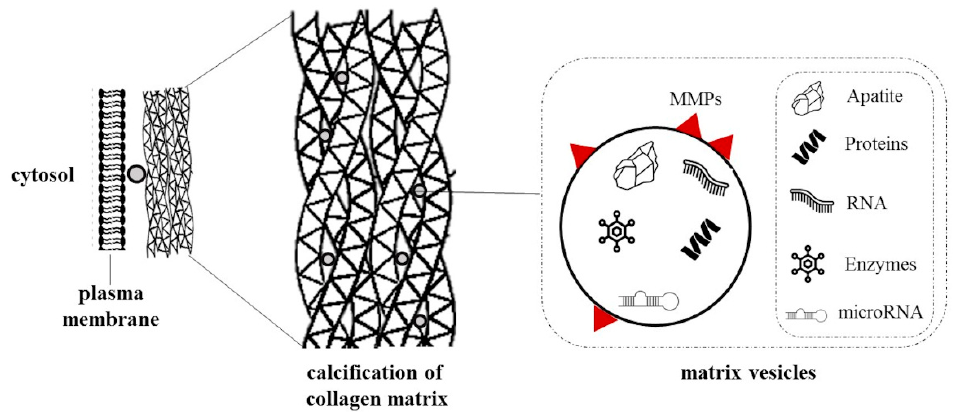
Figure 2. Schematic representation of matrix vesicles. Matrix vesicles are peculiar extracellular ma- trix vesicles that contain various cargoes, including proteins, carbohydrates, lipids, enzymes, RNA, and apatite. Evidence showed that extracellular matrices serve as nucleating foci to initiate micro-